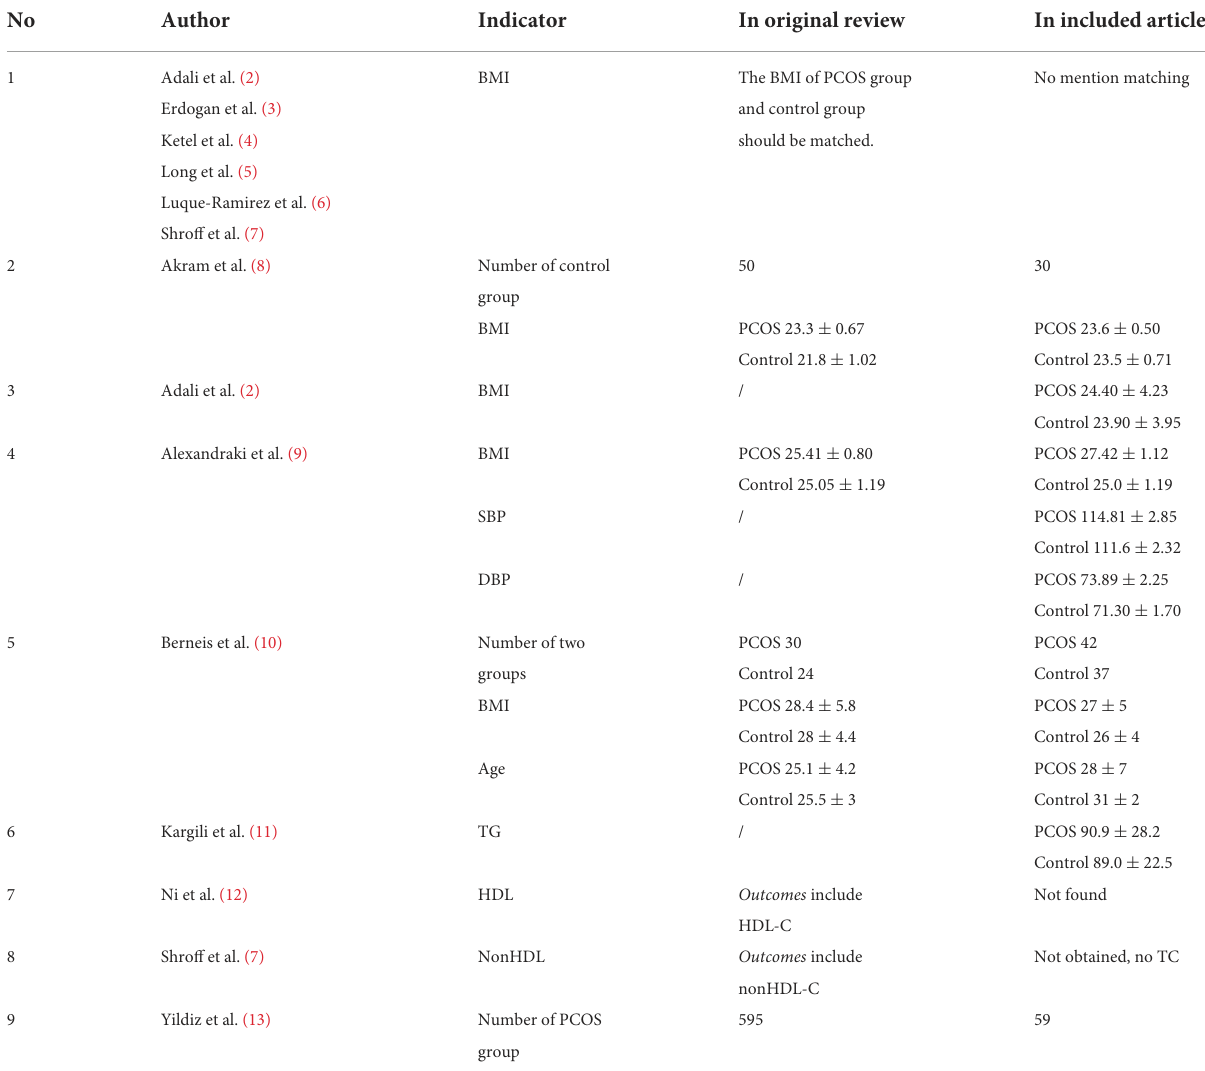
TABLE 1 Extracted information do not match in original review and in included